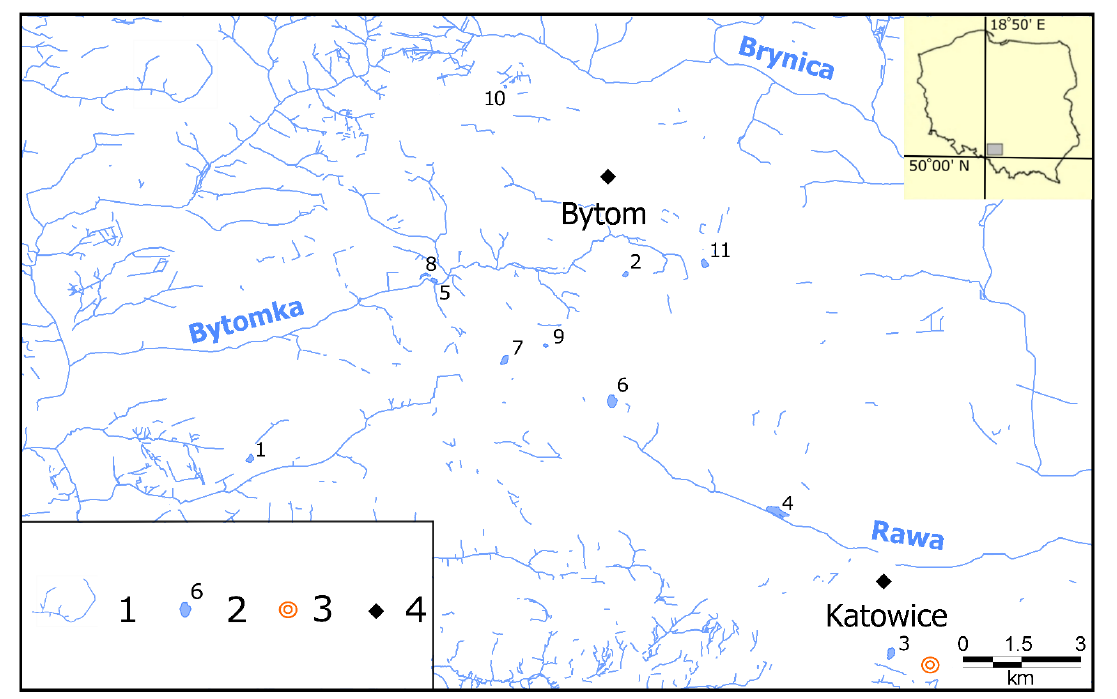
Figure 1. Location of the anthropogenic water bodies studied in the Katowice Upland (southern Poland): 1—rivers; 2—water bodies studied (numbering as in Table 1); 3—meteorological station; 4—major towns. Table 1. Certain morphogenetic and hydrological parameters of the selected water bodies in the Katowice